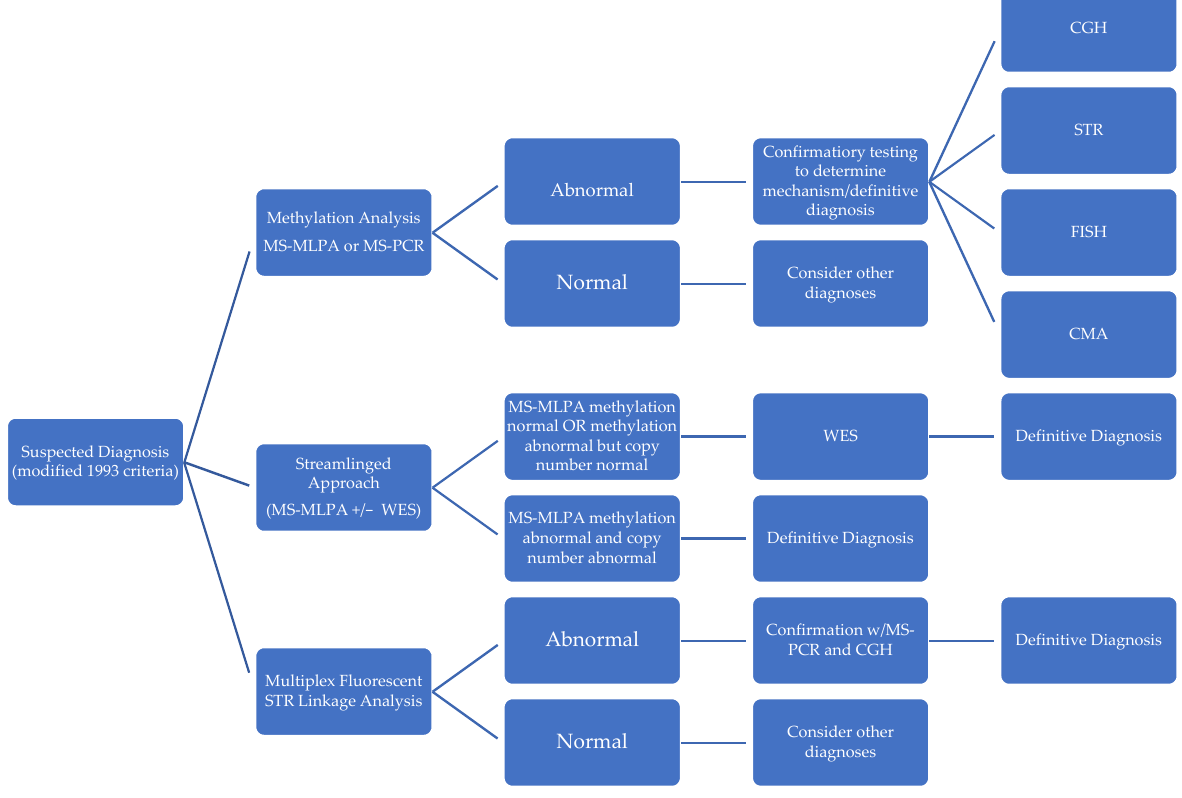
Figure 3. Comparison of diagnostic approaches in PWS.